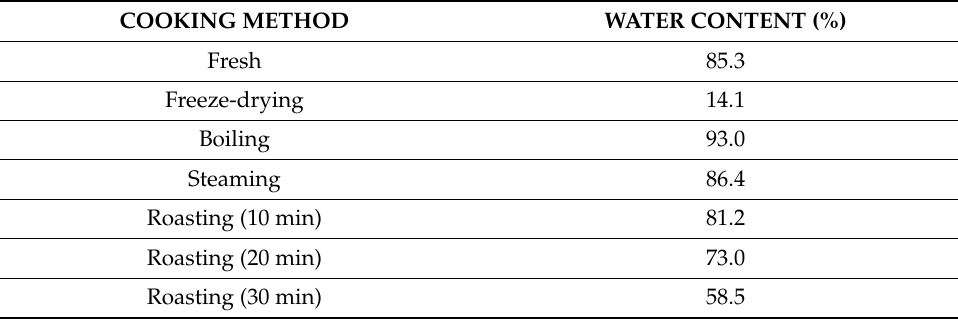
Figure 1. Purple carrots ( Purple Haze variety) cooked by different methods. Table 1. Water content (%) of purple carrots cooked by different methods.